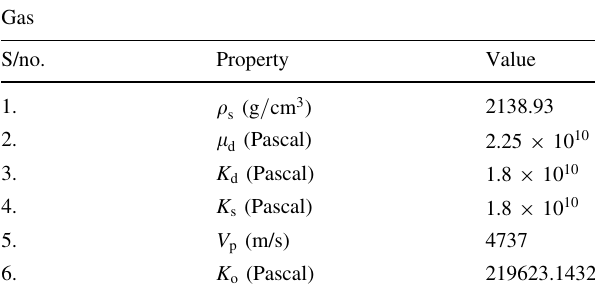
Table 1 Computed properties of gas S/no.